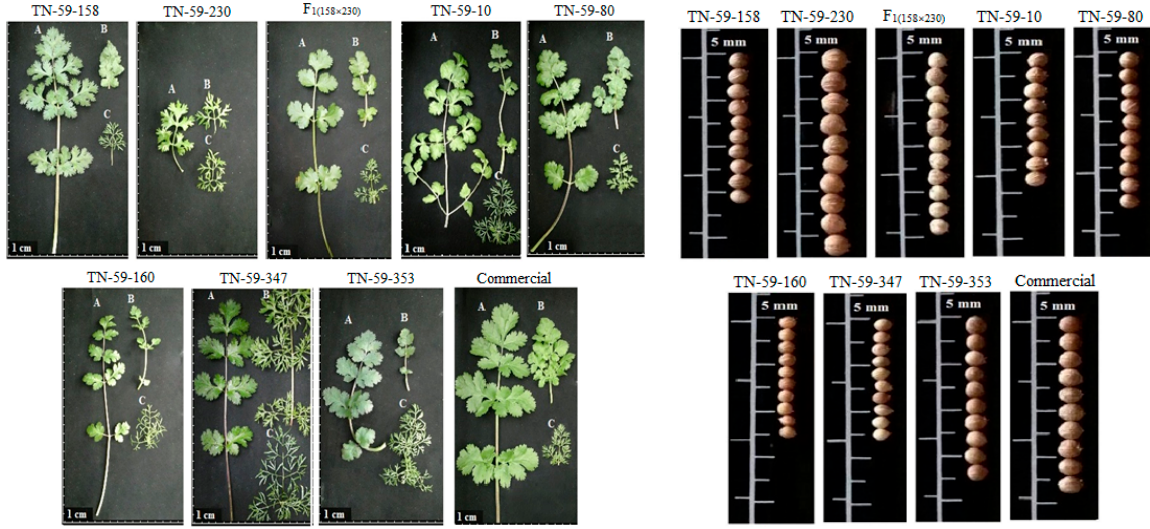
Figure 1. Seed, leaf form, and size of testers and genotypes used in the modified triple test cross. ( A ) longest basal, ( B ) middle, and ( C ) top leaves, respectively.